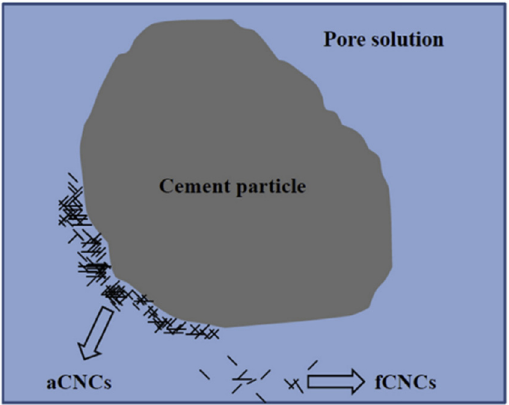
Figure 17: The schematic diagram of two di ff erent types of CNCs in the fresh cement paste, reprinted with permission from ref. [ 43 ] ; Copyright 2016,